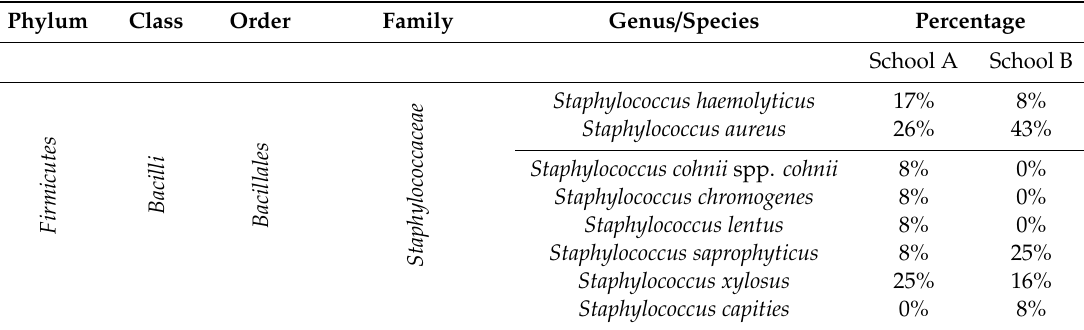
Table 6. Species diversity of the genus Staphylococcus .